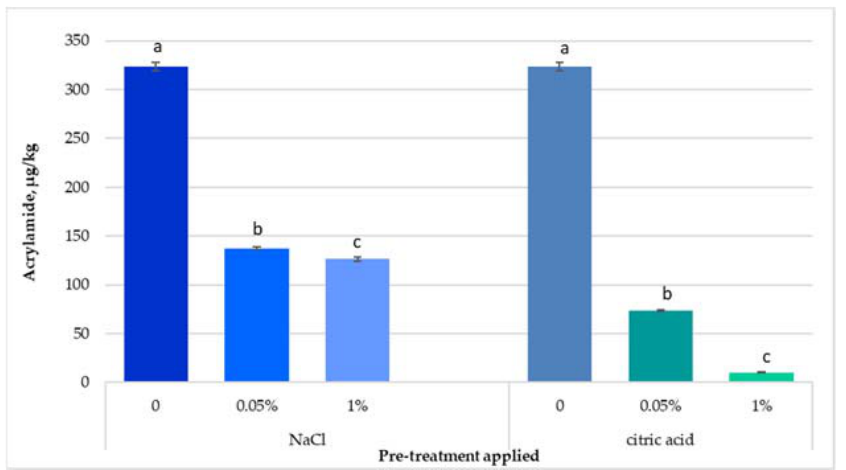
Figure 3. Effect of NaCl and citric acid solutions applied on potato strips on the acrylamide content of French fries fried in a pan. Values followed by different letters in the same column for each pre‐treatment are significantly different ( p < 0.05).